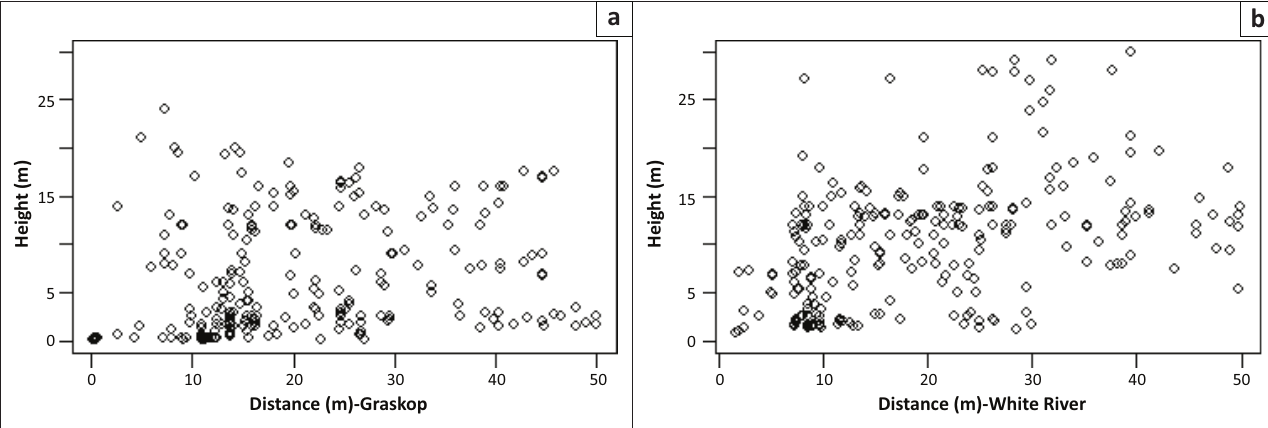
FIGURE 2: Heights of the invasive eucalypts along the 50-m transects. (a) Graskop and (b) White